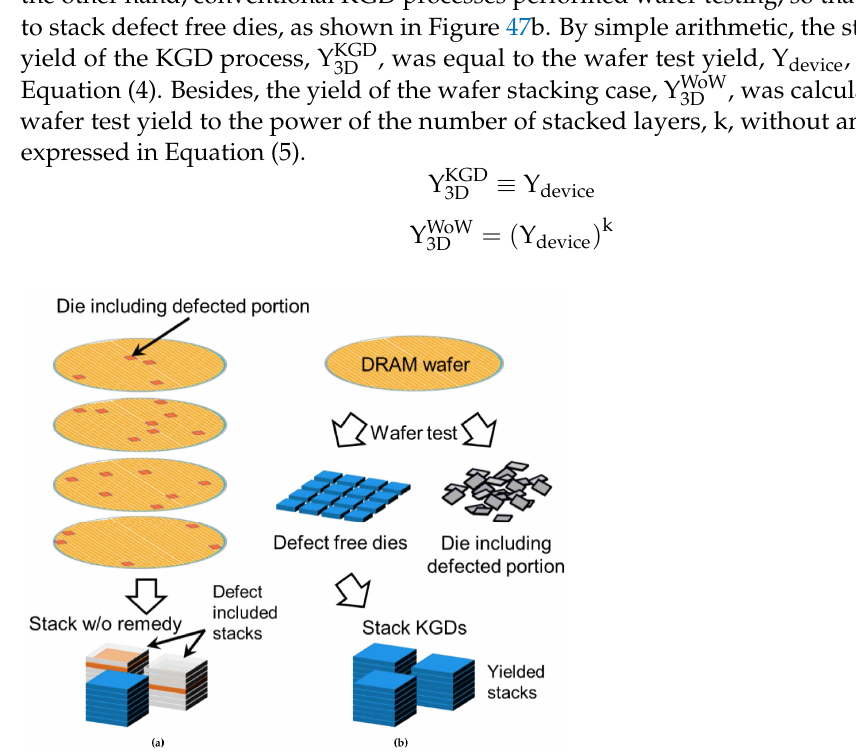
Figure 47. ( a ) For the wafer form fabrication, the probability of randomly defective portions being included in the module stack cannot be eliminated. ( b ) On the other hand, conventional KGD pro- cess includes wafer testing, so that it is possible to stack defect-free dies. 11.1. Method of 3D Redundancy 11.1.1. Typical Configuration of Stacked Synchronous DRAM